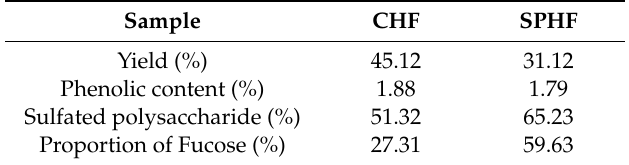
Table 1. Yield, Phenolic content, Sulfated polysaccharide, and monosaccharide content of CHF and SPHF obtained from Hizikia